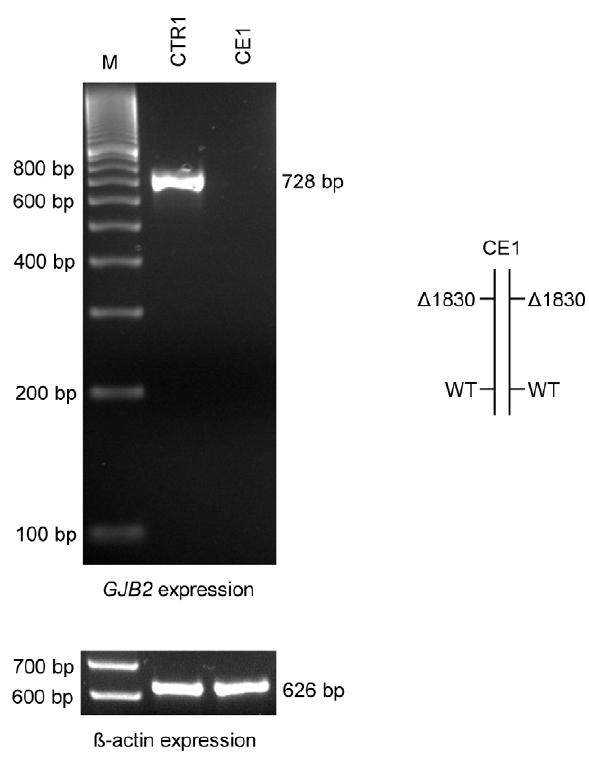
Figure 4. GJB2 expression of a del( GJB6 -D13S1830) homozy- gous patient. PCR amplification was performed after reverse transcription using primers specific for GJB2 cDNA (F1 and R1, Table 2 and Fig 2A). The wild-type control CTR1 amplified a 728 bp segment characteristic for GJB2 while del( GJB6 -D13S1830) homozygous patient CE1 did not express that band at all. ß-actin was used as an RNA expression control. Both samples amplified the expected 626 bp ß-actin band specific for